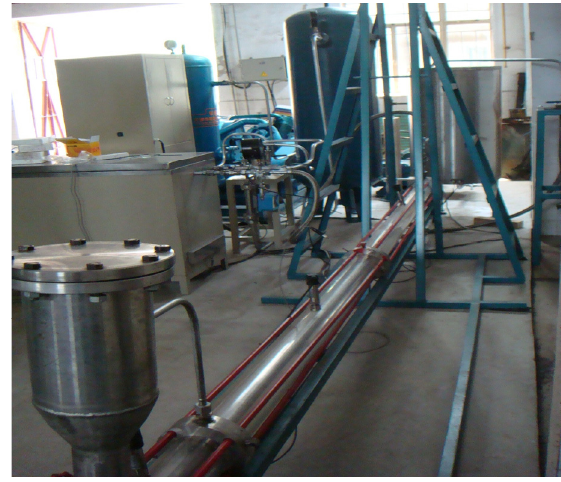
Figure 3. The experimental device for cementing displacement.